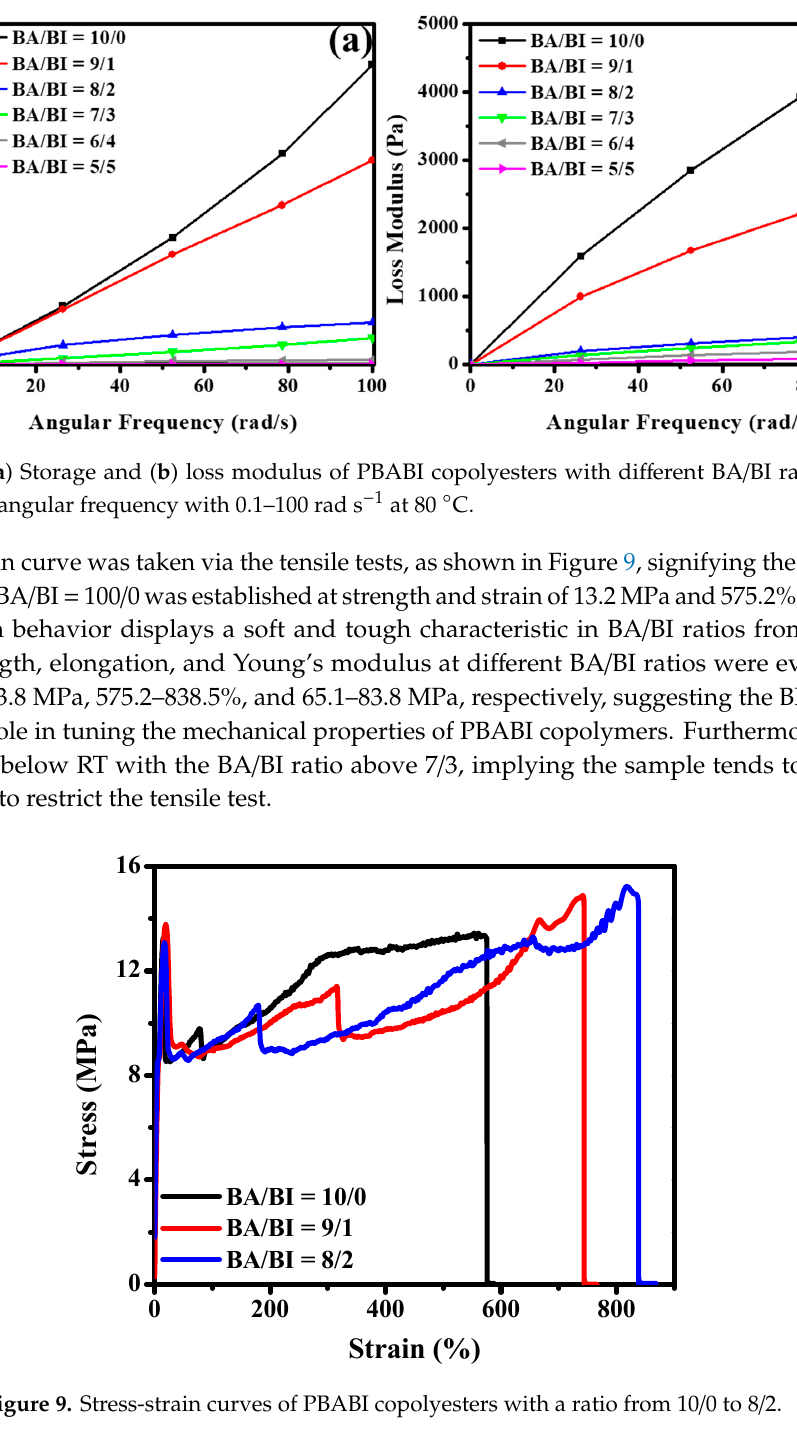
Figure 7. Complex viscosity of PBABI copolyesters with different BA/BI ratios as a function of angular frequency with 0.1–100 rad s − 1 at 80 °C.